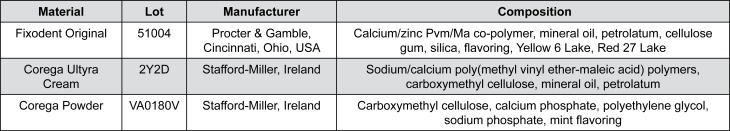
Description of the denture adhesives